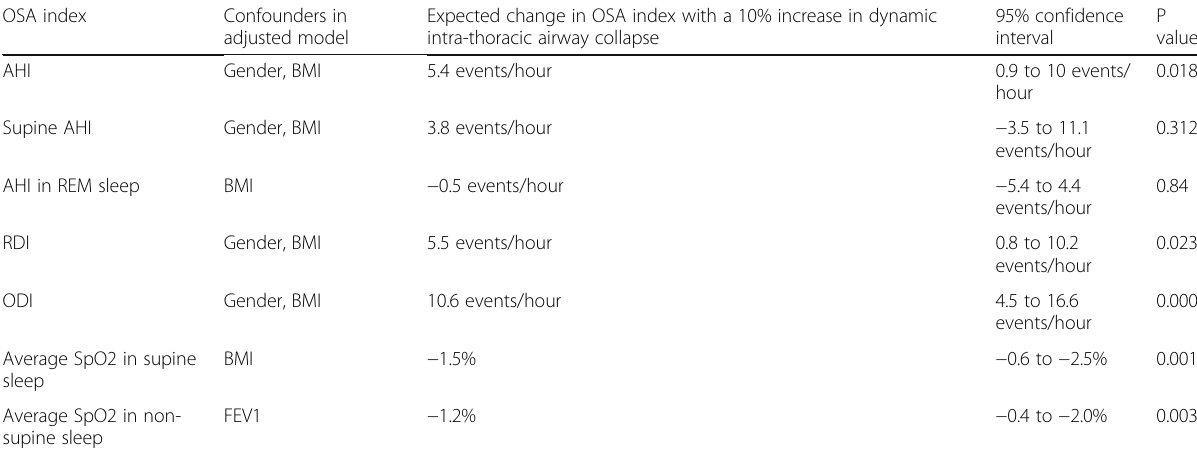
Table 4 Adjusted linear regression models assessing associations between intra-thoracic central airway collapse and